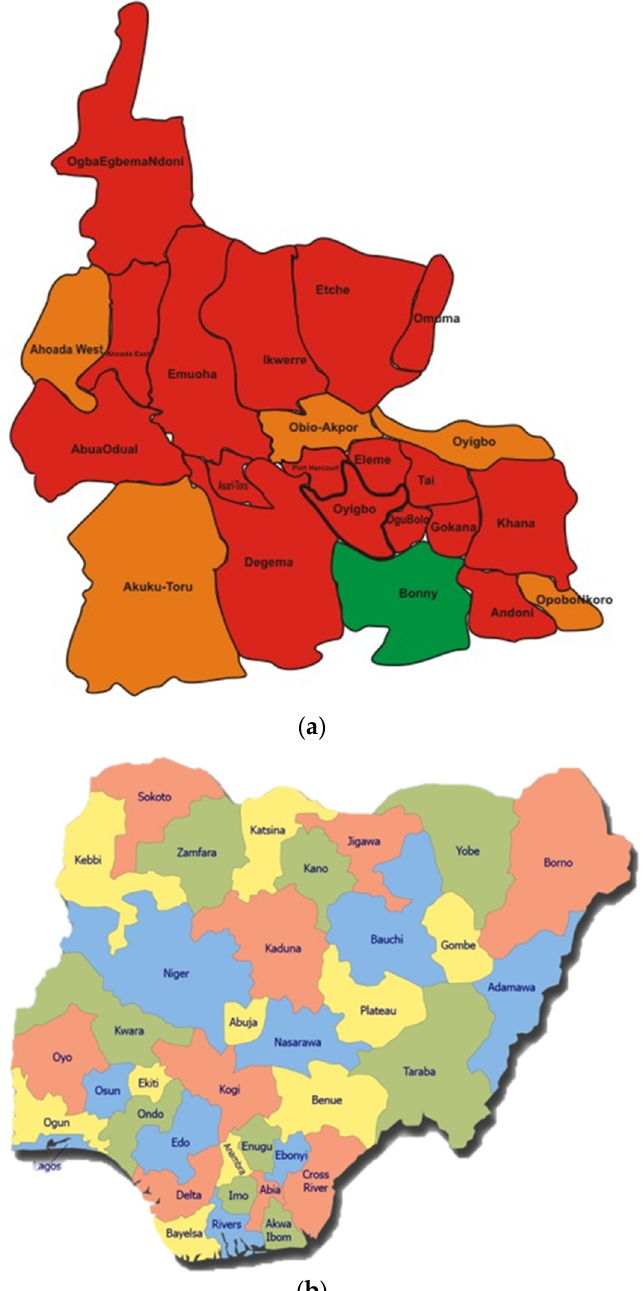
Figure 1. ( a ) Map of Rivers State. ( b ) Map of Nigeria.